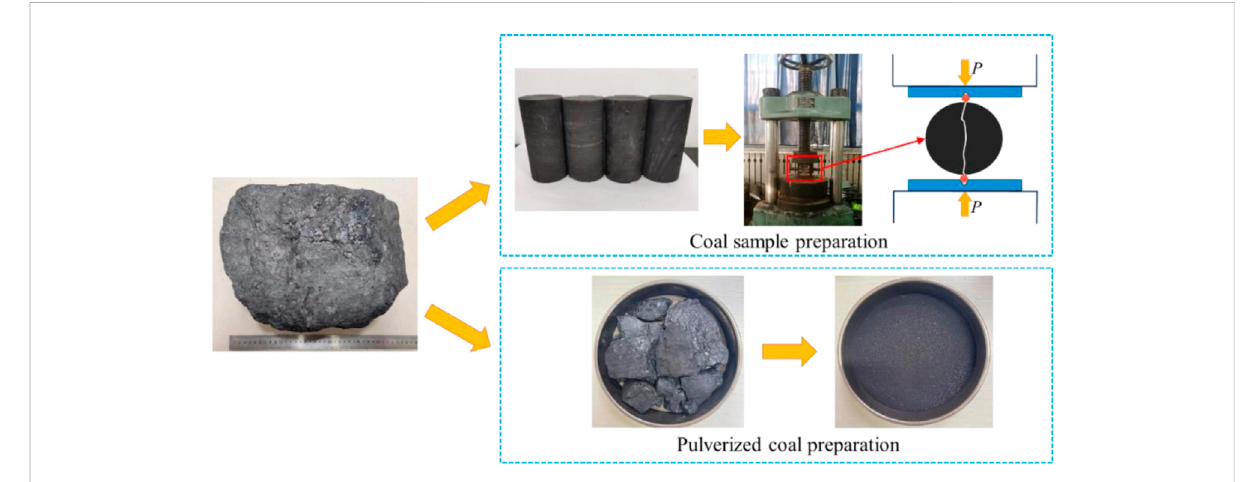
FIGURE 1 Coal sample and pulverized coal preparation.